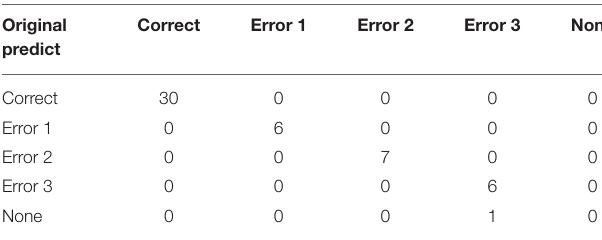
TABLE 4 | Confusion matrix of ICB Image directionality recognition